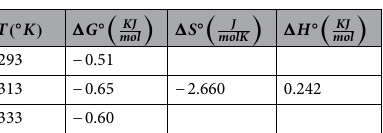
Table 10. Thermodynamic factors for Cu (II) adsorption onto GFLE nanocomposite.